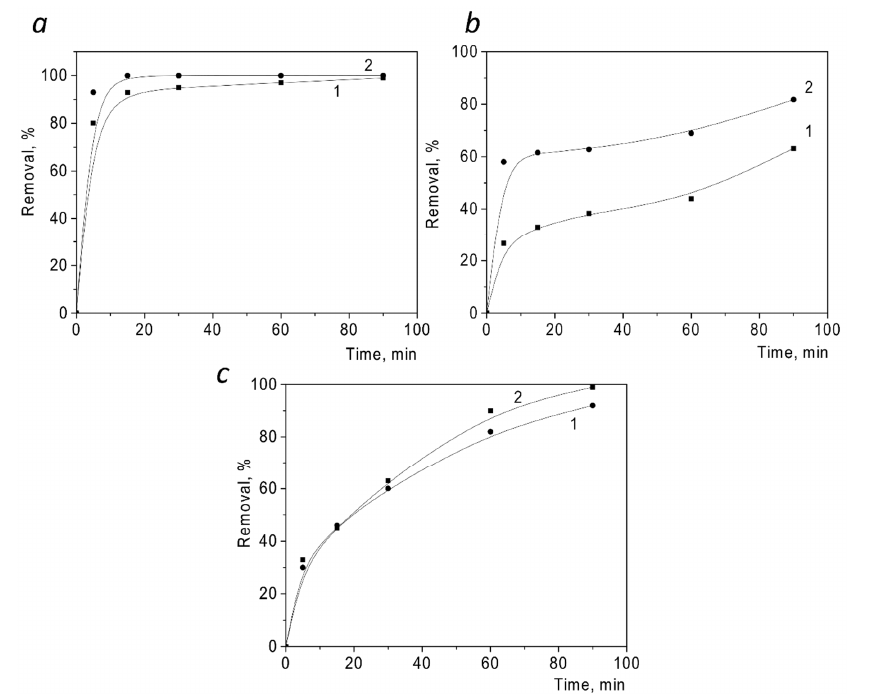
Figure 7. Kinetic curves of adsorption ( a ) Pb 2+ , ( b ) Co 2+, and ( c ) Cu 2+ —ions on Silochrom /PLA (1) and Silochrom ‐ NH 2 /PLA (2). (Experimental conditions: mass of sorbent 0.1 g, the volume of the solution—25 mL, metal content in the solution 100 μ g).